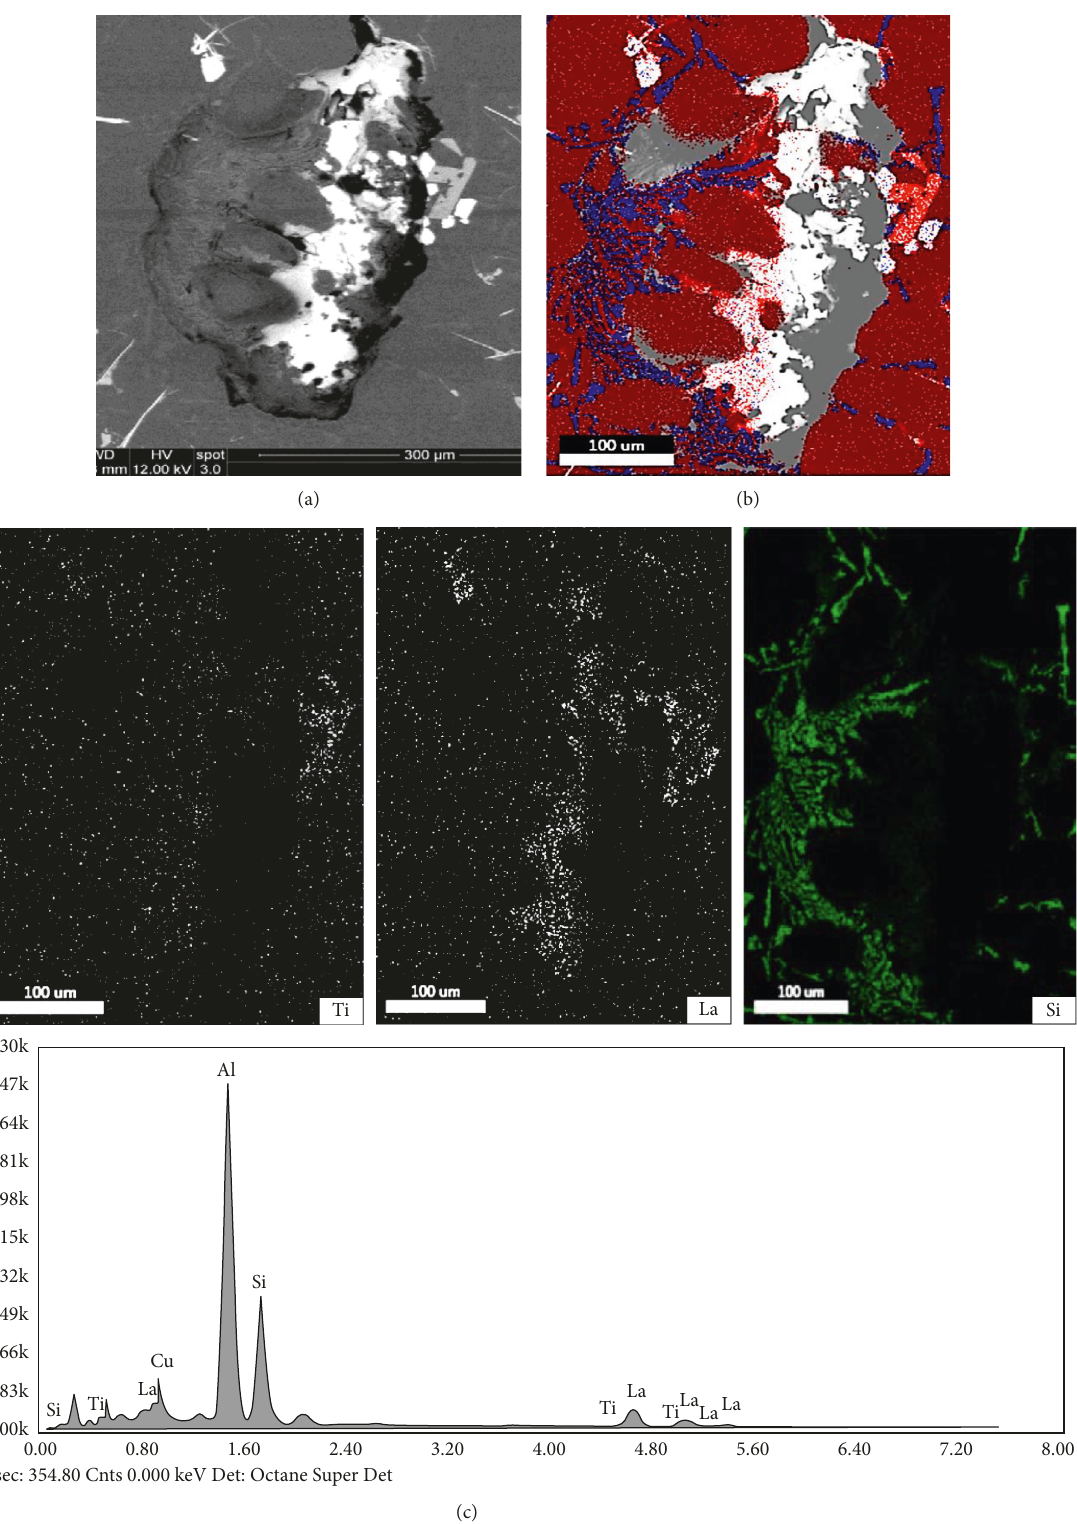
Figure 11: (a) Backscattered electron image and (b) elemental distribution in D0+La +Ti alloy, (c) X-ray images of Ti, La, and Si in (a), showing the presence of La in the RE-rich plate, EDS spectrum corresponding to the white phase marked X in